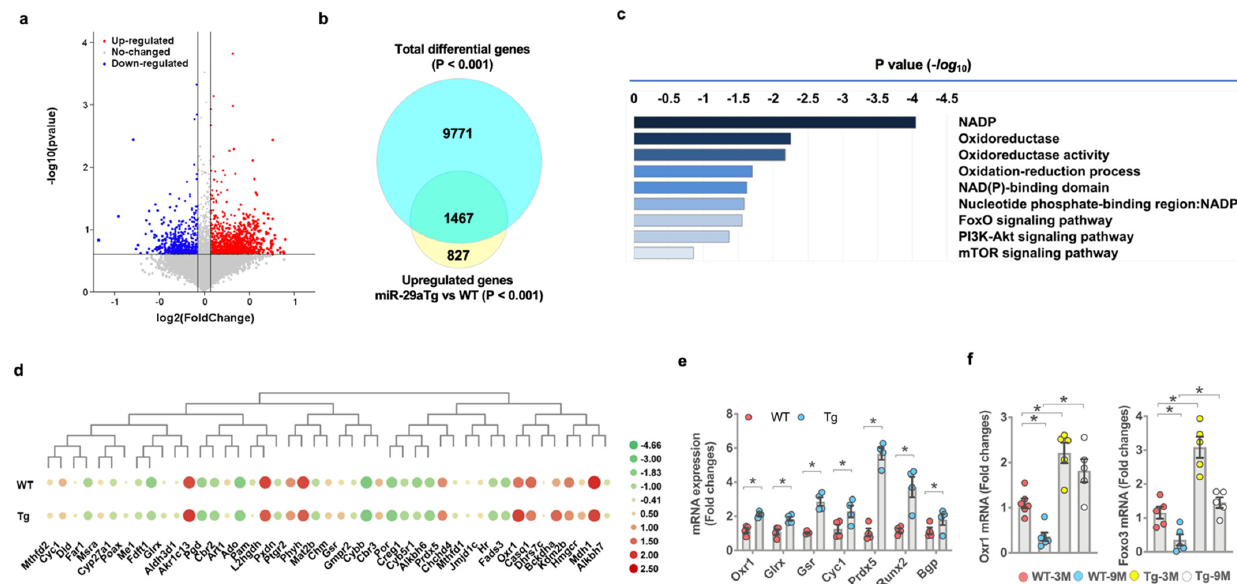
Figure 5. Transcriptomic landscapes of miR-29aTg and wild-type osteoblasts. Volcanic plots showing differential gene expression in osteoblasts between 3-month-old miR-29aTg and WT mice ( a ). Red, blue, and grey spots indicate a gene expression that is upregulated, downregulated, and unaffected, respectively. Venn diagram showing the gene transcripts, which were increased the miR-29aTg group ( b ). Pathway ontology analysis revealing significantly affected biological reactions in the miR-29aTg group ( c ). Heatmap of transcriptomic profile showing 45 gene transcripts in redox reactions ( d ). Transcriptomic profiles of miR-29aTg and wild-type osteoblasts were analyzed in 3 mice. Orx1 , Glrx , Gsr , Cyc1 , Prdx5 , Runx2 , and Bgp mRNA expression was increased in miR-29aTg osteoblasts, as evidenced in RT-PCR analysis ( e ). Significant difference of investigations (mean ± standard error, n = 4 mice) was analyzed using a Student’s t -test. Orx1 and FoxO3 loss in bone-marrow mesenchymal cells was compromised in old miR-29aTg mice ( f ). Significant differences (asterisks *) of investigations (n = 5 mice) were analyzed using an ANOVA test and a Bonferroni post hoc test.